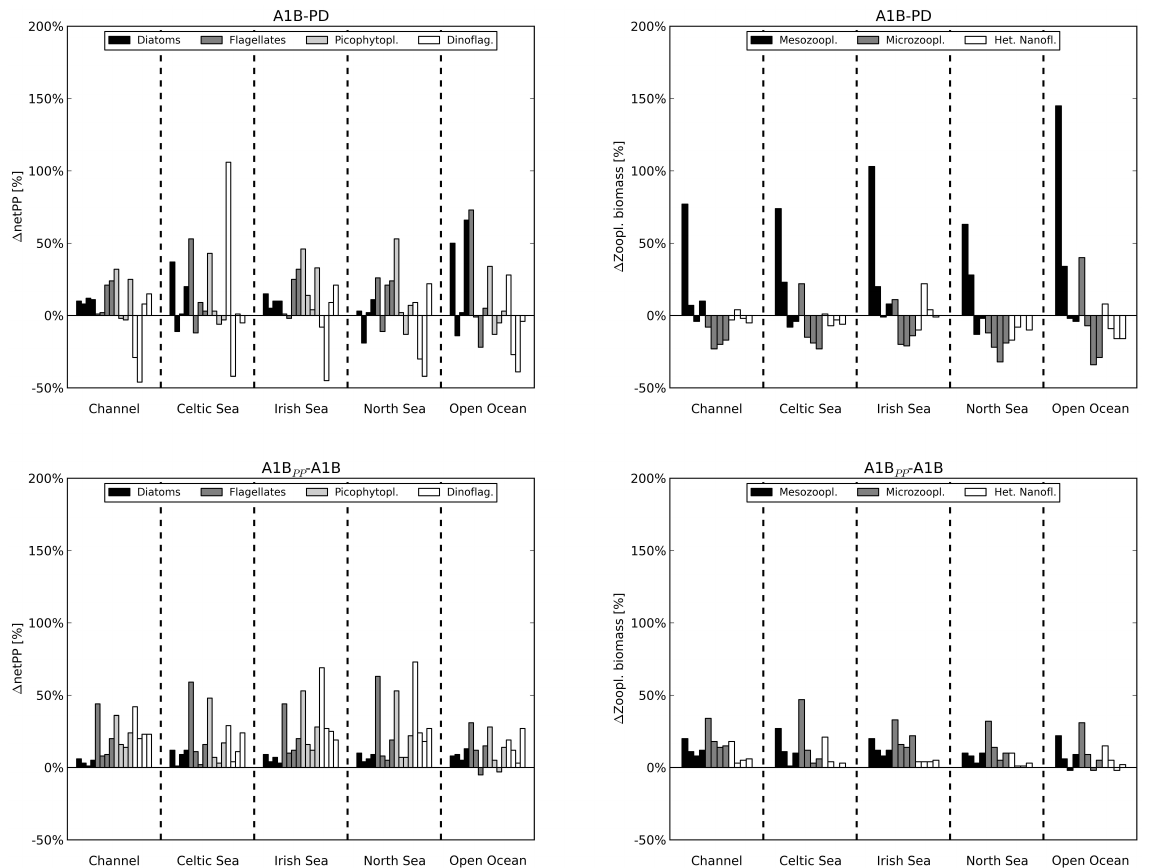
Fig. 5. Relative difference between the seasonal mean of net primary production (a, c) and zooplankton biomass (b, d) , shown for different sub-regions. (a, b) show the difference between the A1B (future climate) scenario and the PD (present day) scenario (A1B-PD); (c, d) show the difference between the enhanced production run and the A1B scenario (A1Bpp − A1B). Colour of the bars denotes the plankton functional type. The four adjacent bars for each functional type, within each region, represent the seasons, in the order winter, spring, summer,